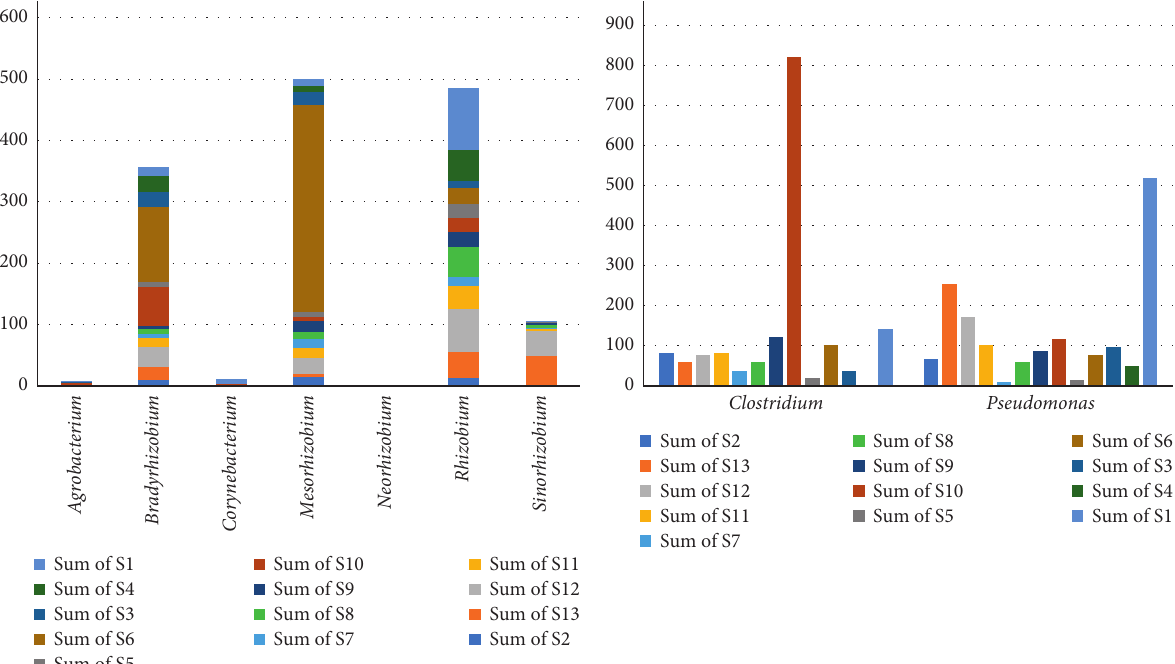
Figure 17: Relative abundance of zeatin-producers and Clostridium and Pseudomonas spp